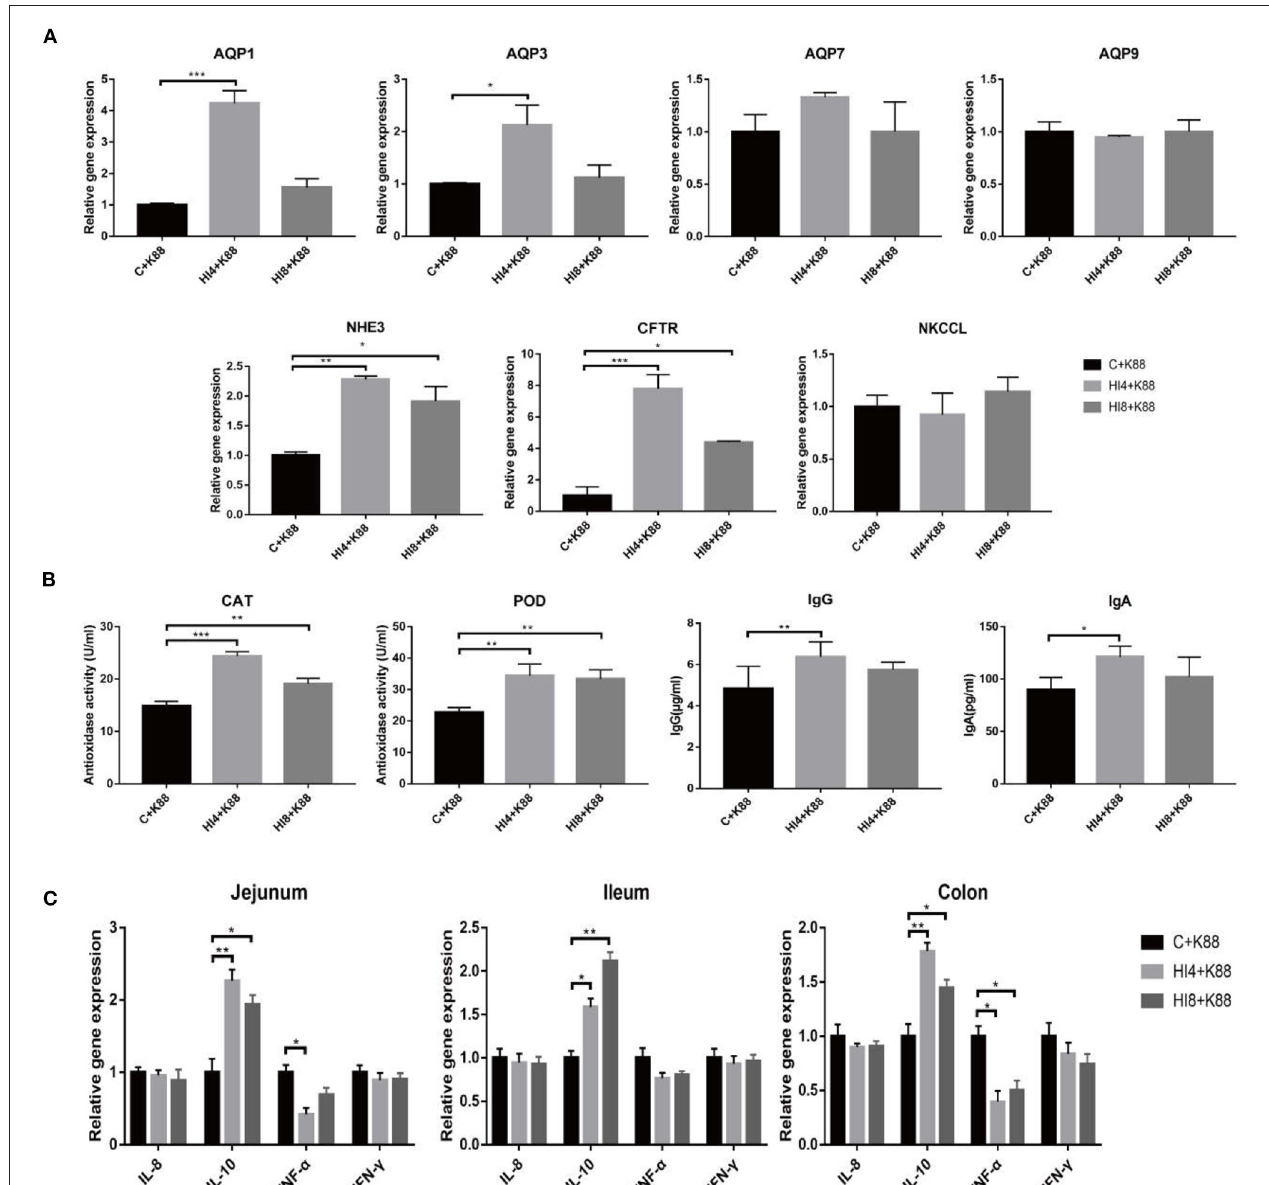
FIGURE 4 | The challenge of ETEC affects the expression of ion transporter and aquaporin in the ileal mucosa of piglets, the content of antioxidant enzymes and immunoglobulins in serum, and the expression of inflammatory factors in the intestinal mucosa. (A) The relative mRNA expression of intestinal ion transporters and aquaporins ( AQP ) in ileum mucosa. AQP , aquaporins; CFTR , cystic fibrosis transmembrane conductance regulator; NHE3 , Na + /H + exchanger 3; NKCC1 , Na-K-Cl cotransporter. Results are mean ± SD ( n = 4). (B) Antioxidant enzyme activity and immunoglobulin concentration in serum of challenged weaned piglets (One-way ANOVA with a Tukey post-hoc test) ( n = 4). (C) Effects of dietary supplementation of Hermetia illucens larvae on real-time mRNA expression of cytokines and barrier function genes in jejunal mucosa, ileum mucosa, colon mucosa (One-way ANOVA with a Tukey post-hoc test) ( n = 4). * P < 0.05, ** P < 0.01, *** P < 0.001, ( n =